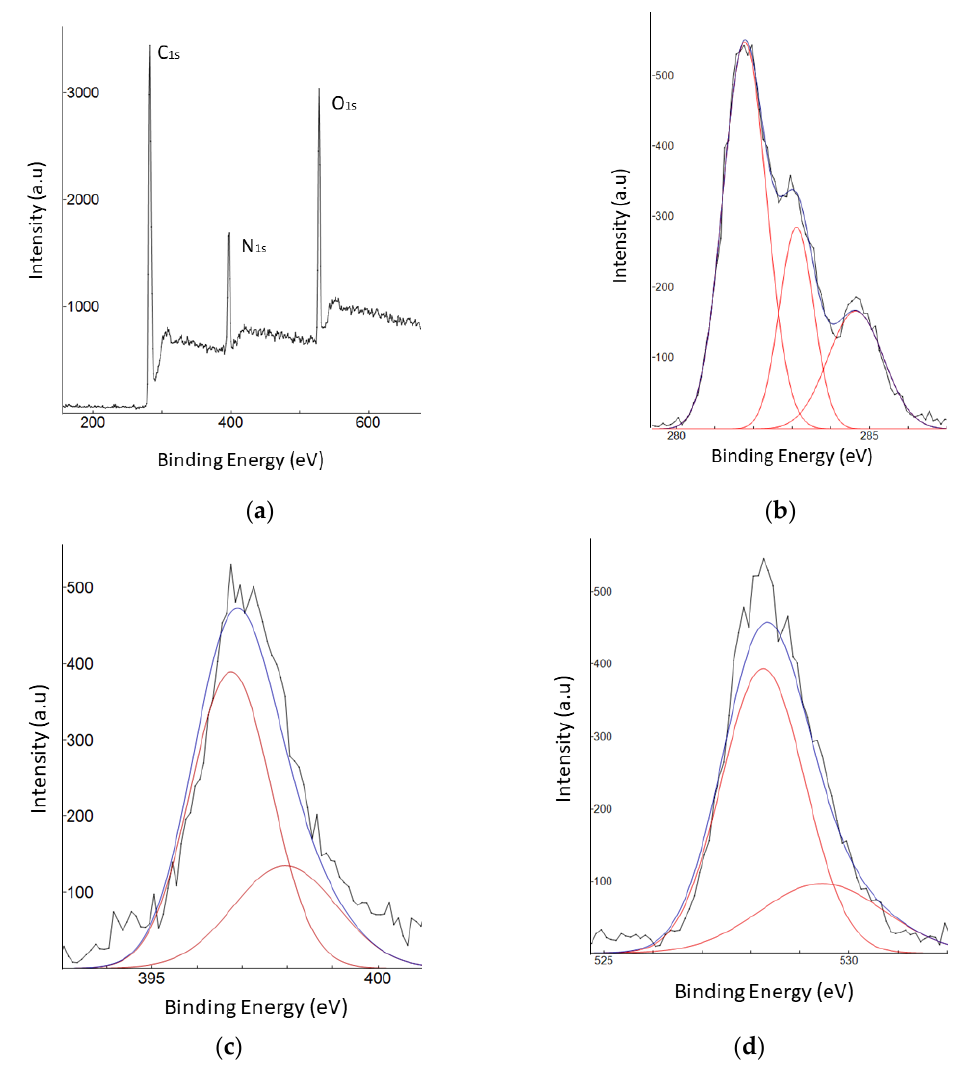
Figure 5. XPS spectrum ( a ) and high-resolution XPS spectrum of ( b ) C1s, ( c ) N1s, and ( d ) O1s for CDs.